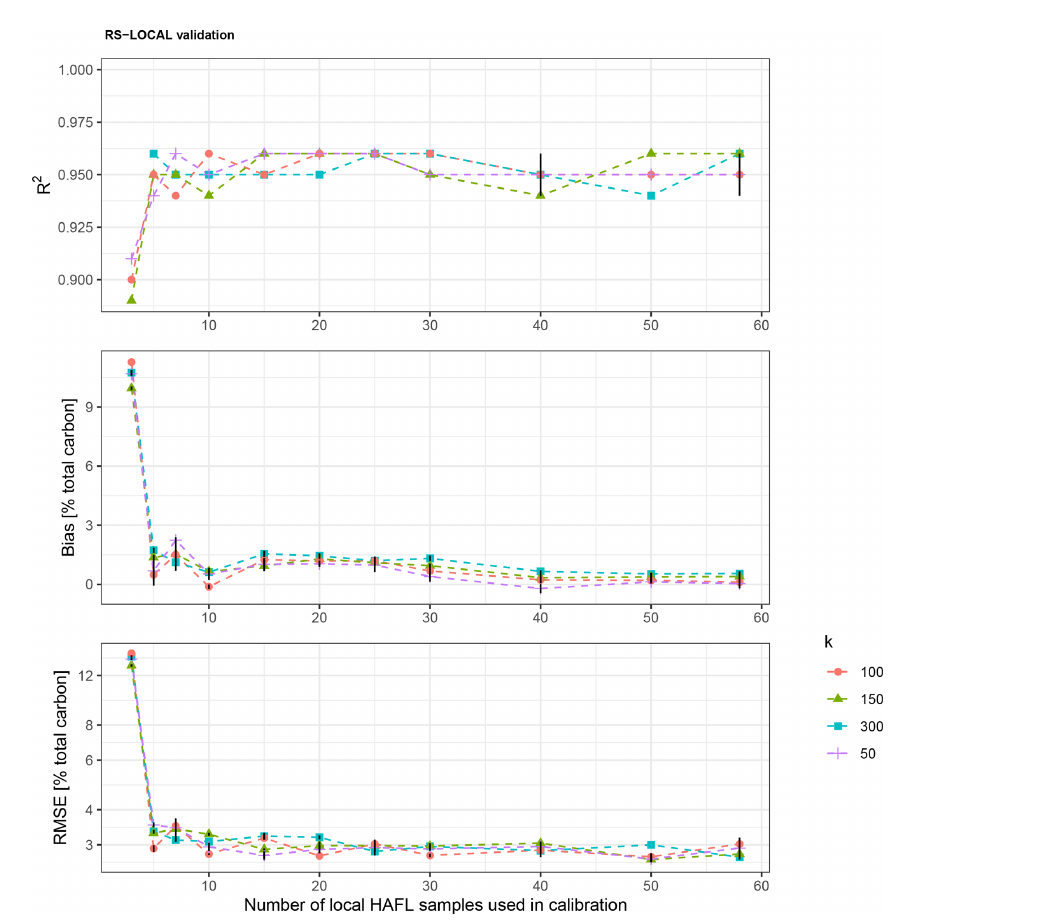
Figure D1. R 2 , bias and RMSE (percent total carbon) of the validation of RS-LOCAL modeling approaches, using different numbers of local HAFL samples in model calibration, when altering the RS-LOCAL parameter k . The RMSE is on a logarithmic